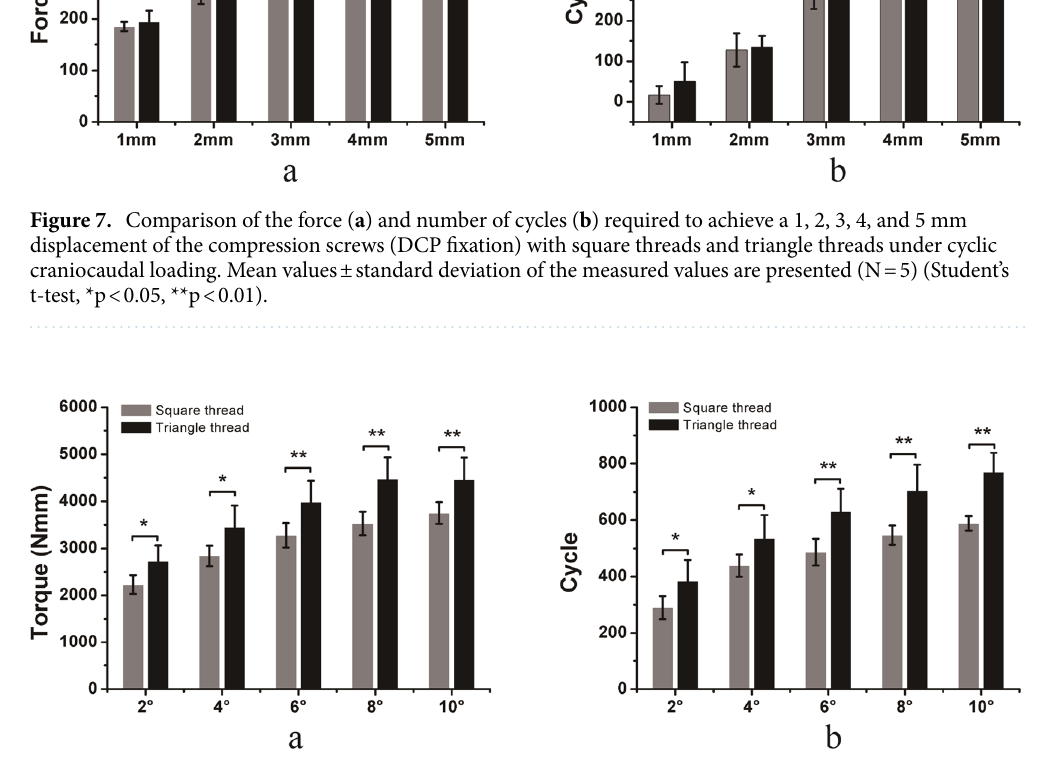
Figure 8. Comparison of the torque ( a ) and number of cycles ( b ) required to achieve 2, 4, 6, 8, and 10 degrees of torsion of the compression screws (DCP fixation) with square threads and triangle threads under cyclic torsional loading. Mean values ± standard deviation of the measured values are presented (N = 5) (Student’s t-test, *p < 0.05, **p <